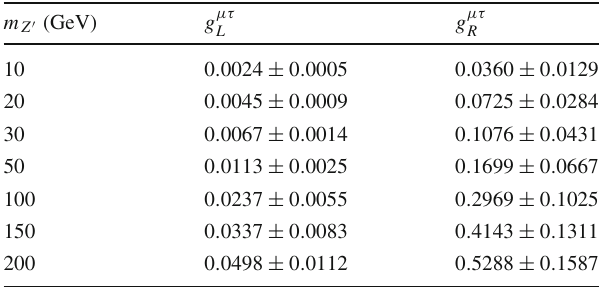
Fig. 12 Tau-pair production cross sections, σ(μ + μ − → τ + τ − ) as a sponding SM predictions (at leading order). The right panel offers a √ s . The shaded regions corre- function of m Z (cid:2) for different values of detailed view of the light regime for the Z (cid:2) ( m Z (cid:2) (cid:3) 50 GeV) spond to the fit uncertainty, while the dashed lines denote the corre- Table 3 Predicted cross sections (pb) for different energies Table 2 Best fit values and associated uncertainties of the μ − τ cou- masses, with − 0 . 99 ≤ cos θ ≤ 0 . plings for different Z (cid:2) masses; the fit includes ( g − 2 ) μ , R Z αβ and R τ μ e constraints